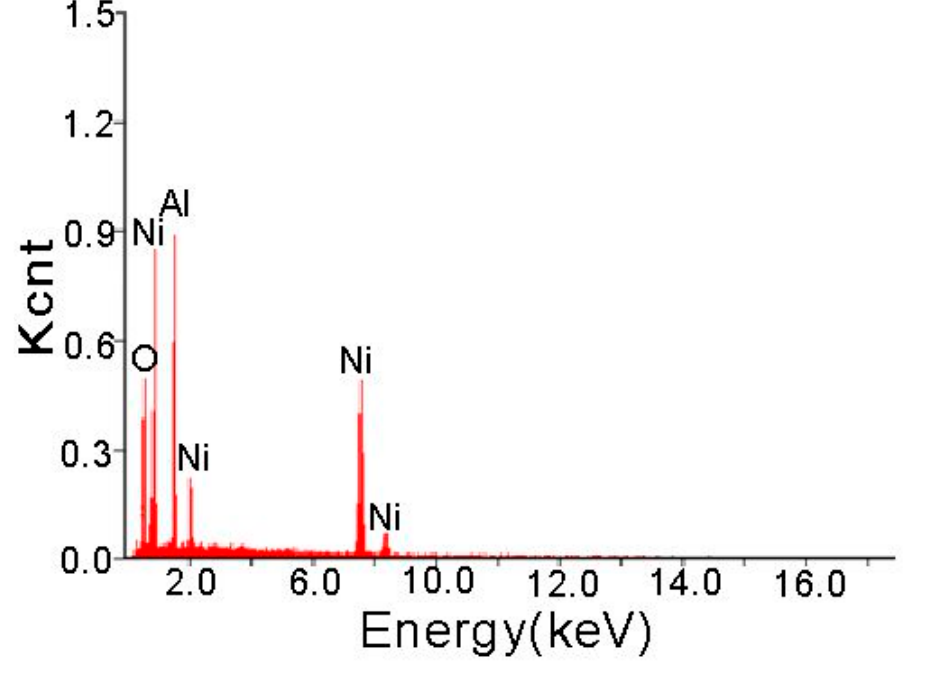
Figure 3. EDX spectrum of the Ni/n–Al 2 O 3 layer.